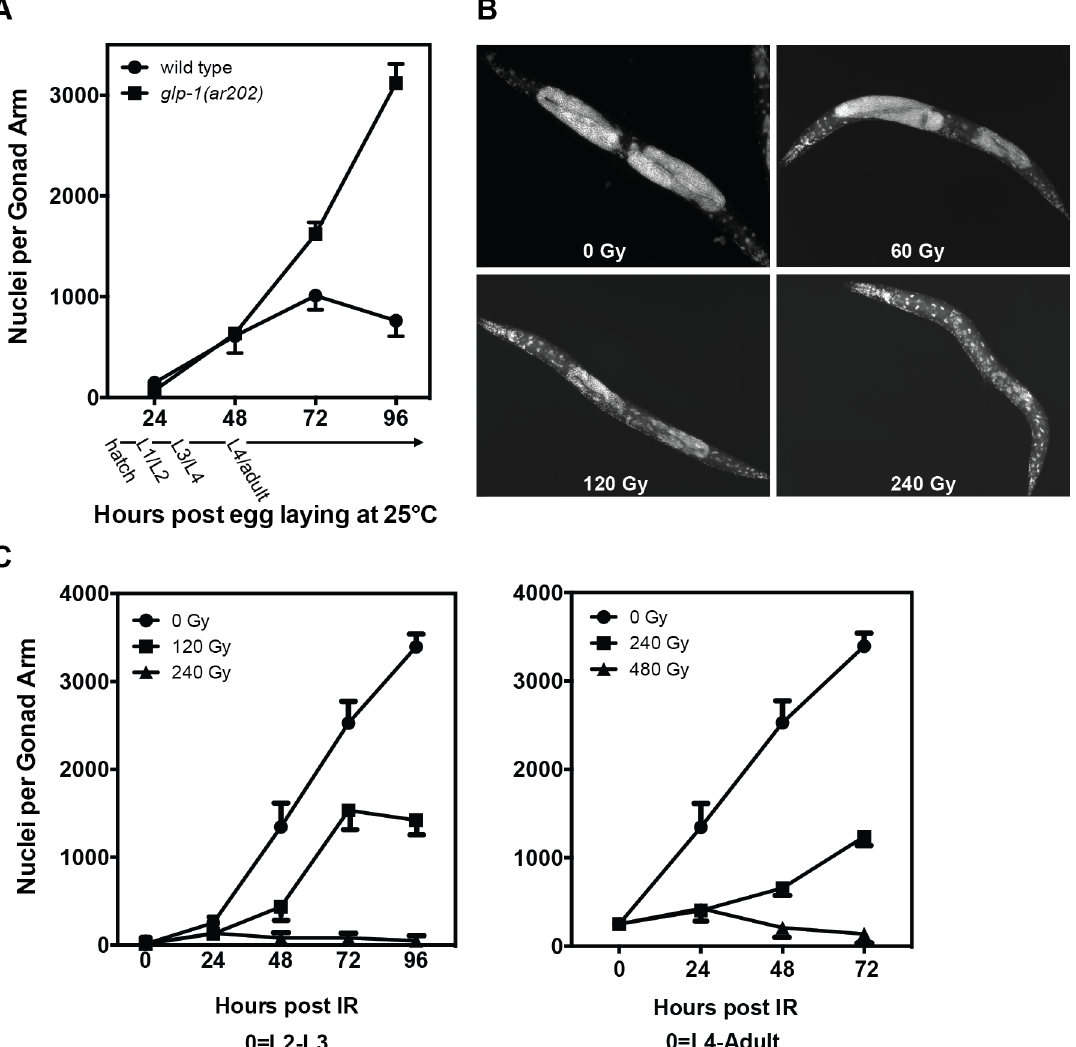
Fig 1. Response of C . elegans germline tumors to ionizing radiation. (A) Time course of germ cell accumulation in wild-type and glp-1(ar202) hermaphrodites. Worms were stained with DAPI at the indicated times after egg laying and imaged (20x magnification). Data (mean ± s.e.m) represent number of germ nuclei ⁄ gonad in a minimum of 10 gonad arms. (B) Representative images of germline tumors in adult glp-1(ar202) post radiation. Worms were irradiated at the L2-L3 stage (30h after egg laying) and DAPI stained at 40h post irradiation. (C) Stage sensitivity of germline tumors to ionizing radiation. glp-1(ar202) were irradiated at the L2-L3 or late L4 stage, and quantified as in (A). All experiments were performed at 25°C as described in